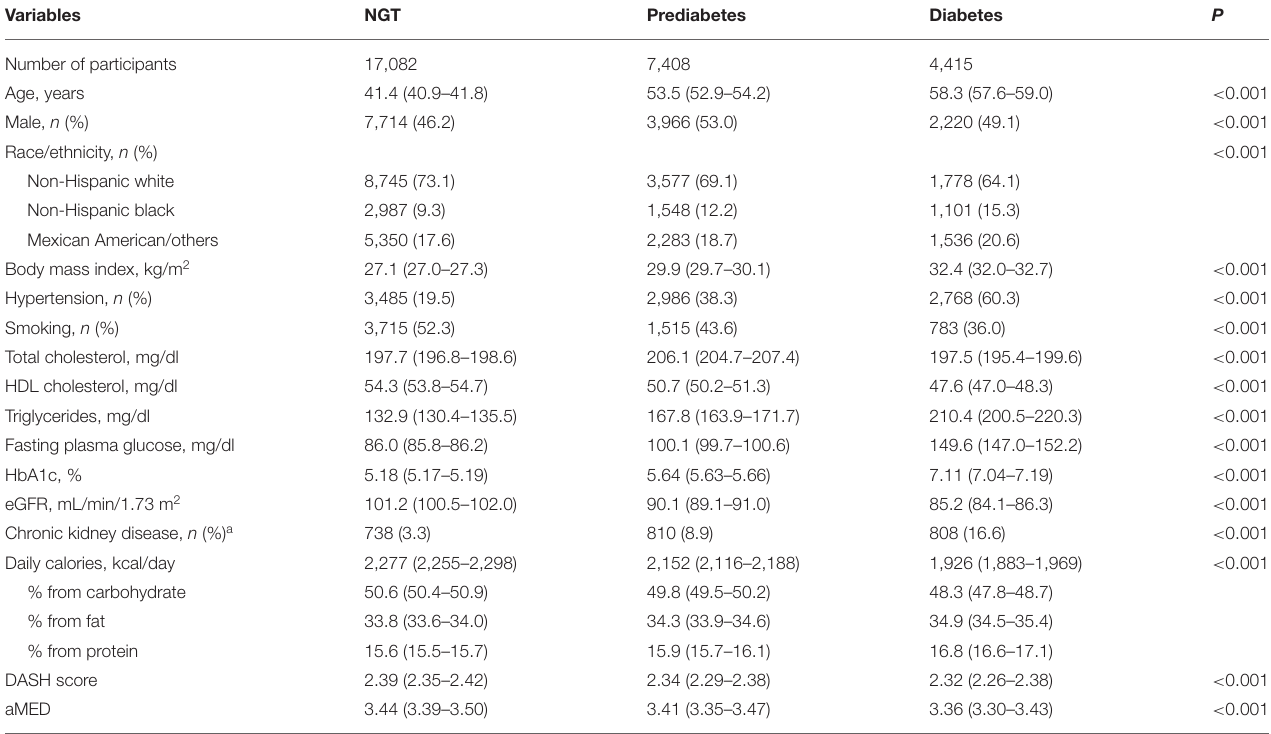
TABLE 1 | Characteristics of study participants according to their glucose regulation status. Variables NGT Prediabetes